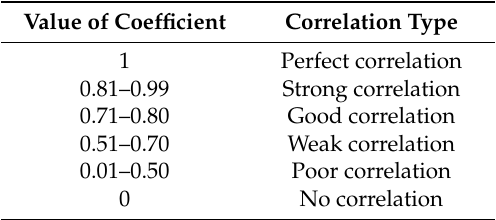
Table 4. Interpretation of the strength of the correlation